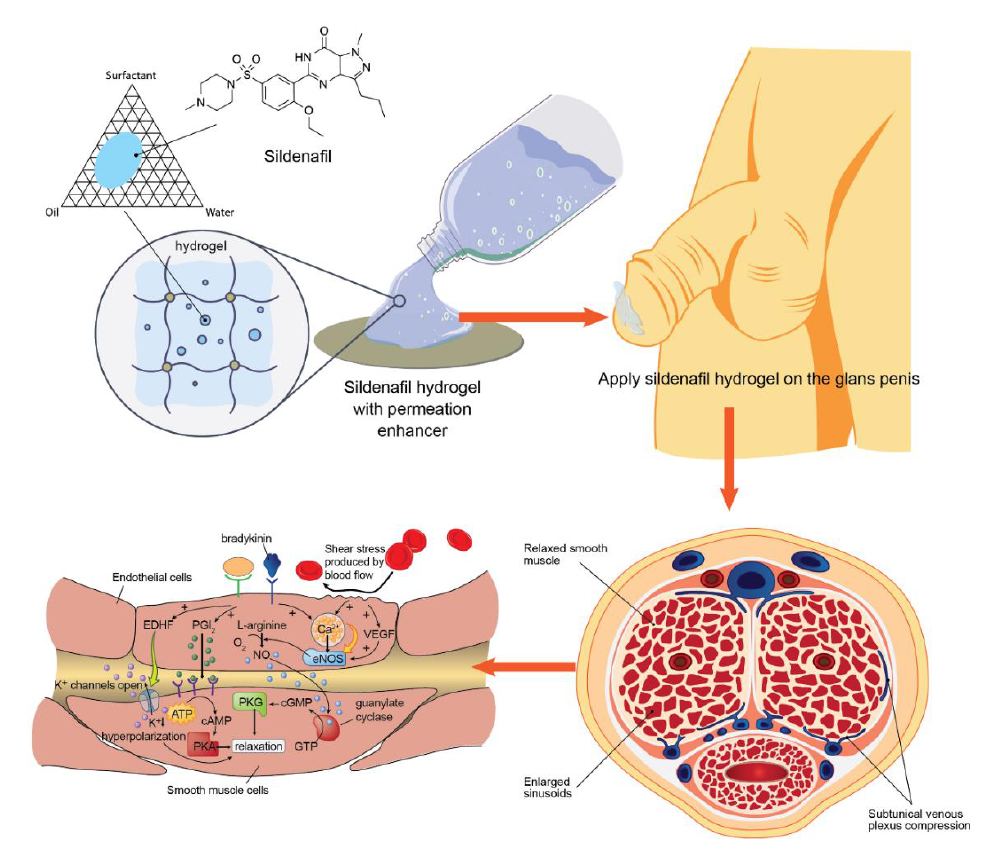
Figure 1. Schematic diagram of the sildenafil microemulsion-loaded hydrogels for transdermal drug delivery directly to the penis and smooth muscle cell relaxation mechanism (EDHF is endothelium derived hyperpolarizing factor; PGI 2 is prostacyclin; NO is nitric oxide; eNOS is endothelial nitric oxide synthase; VEGF is vascular endothelial growth factor; ATP is adenosine triphosphate; GTP is guanine triphosphate; cAMP is cyclic adenosine monophosphate; cGMP is cyclic guanosine monophosphate; PKA is protein kinase A; PKG is protein kinase G).